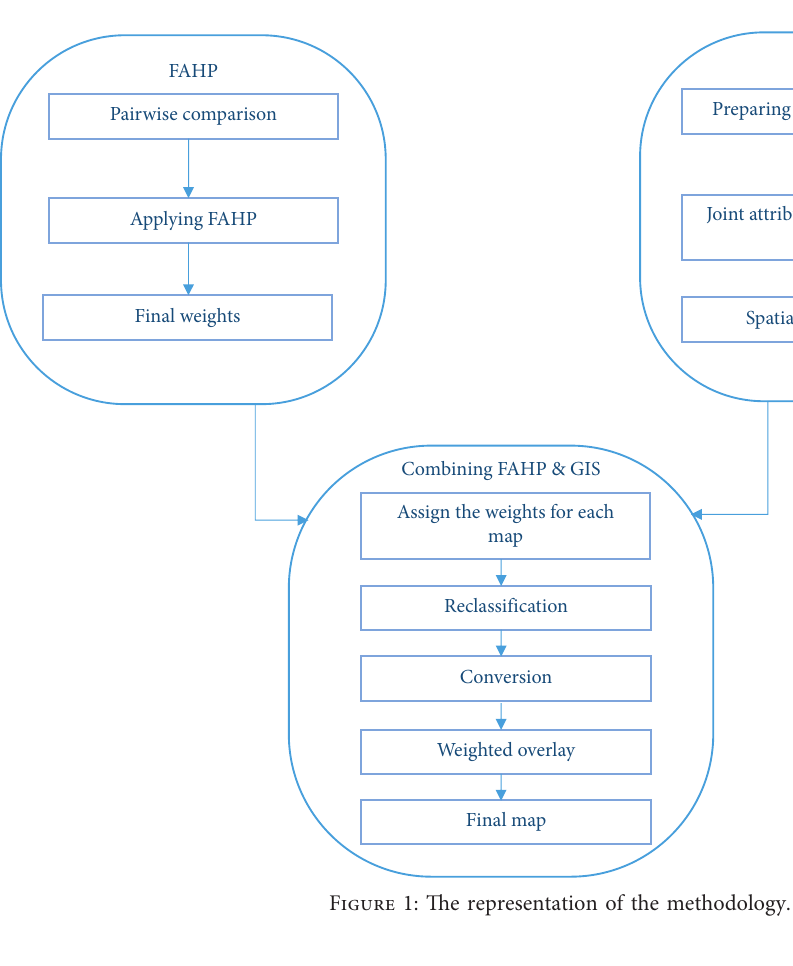
Figure 1: The representation of the methodology.